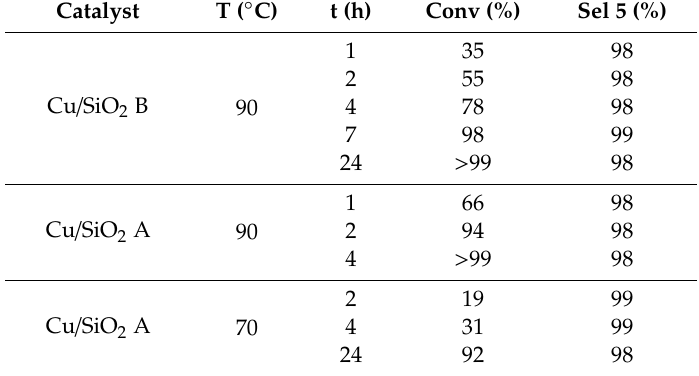
Table 3. Trans-phenyl-styrylsulfone hydrogenation reactions with silica-supported Cu catalysts at 1 Bar of H 2 .